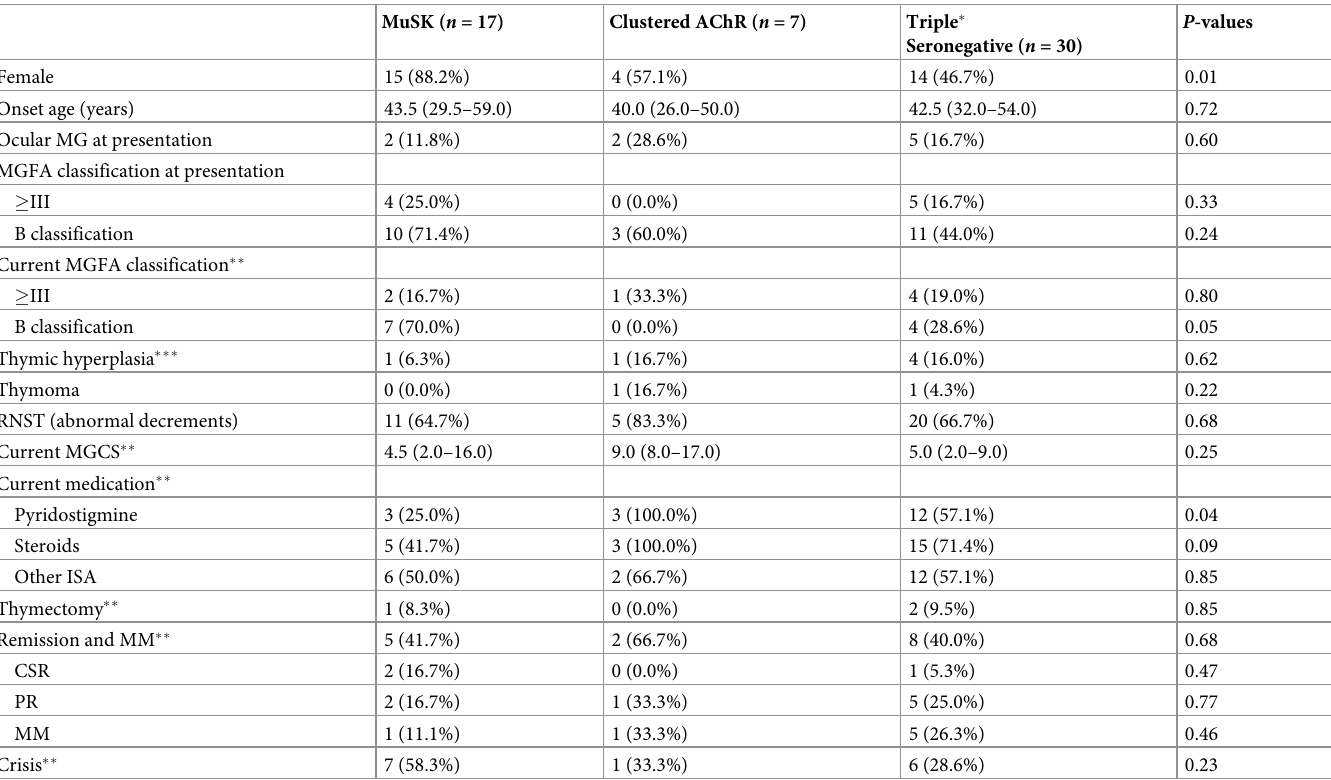
Table 1. Clinical features of AChR antibody seronegative generalized MG (on radioimmunoprecipitation assay) according to the antibody profile. MuSK ( n =